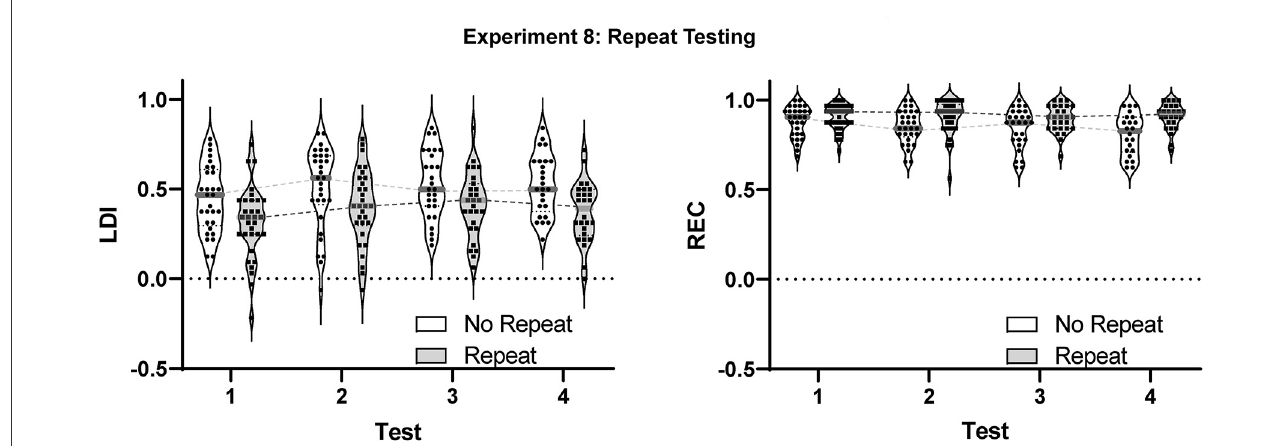
FIGURE5 Results from Experiment 8 examining the effect of multiple testing on the LDI and REC measures in the MST. A modest, but reliable effect was observed in the LDI between the first test and all other test sessions. Violins show distribution with individual subject data included. Gray bars represent median values.